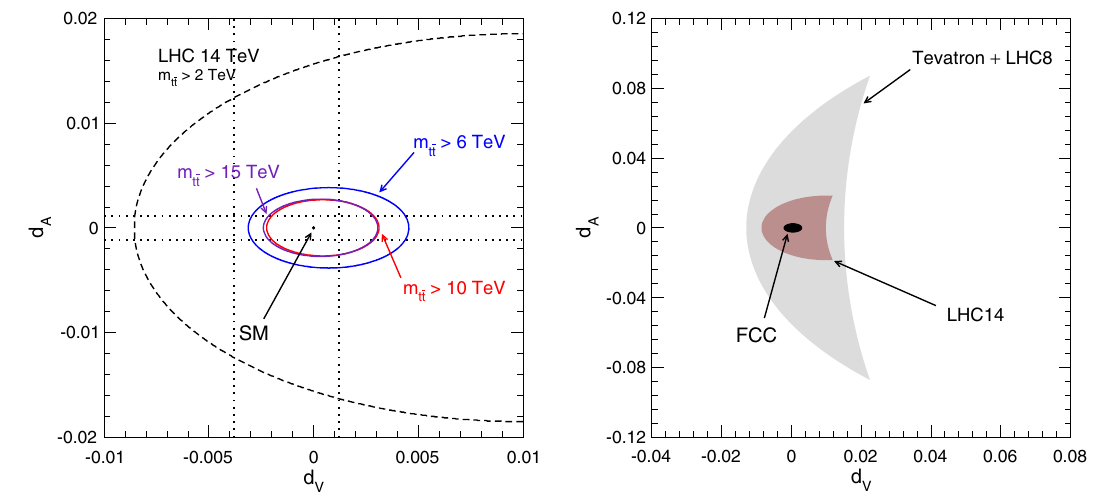
√ Fig. 6.6 (Left) Sensitivity of the s = 14 TeV LHC, and the √ nitions for the boosted regime at the FCC are shown. (Right) A compar- s = 100 TeV FCC to the chromomagnetic and chromoelectric dipole ison of constraints on d V and d A from past, present, and future hadron moments d V and d A from high-mass t¯t production. Three different defi- colliders. For more details, see Ref. [171]